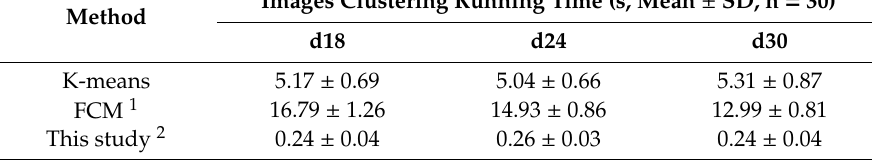
Table 1. Comparison between different methods in processing (clustering) speed for 30 images on different days.